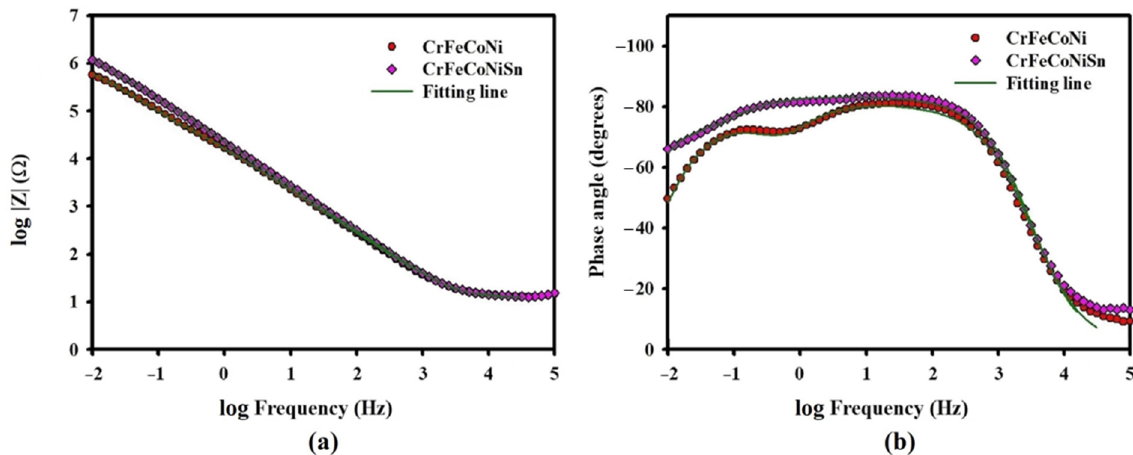
Figure 7. ( a ) The Bode plots and ( b ) Bode phase plots of CrFeCoNi and CrFeCoNiSn alloys in 0.6 M NaCl solution at ambient temperature.